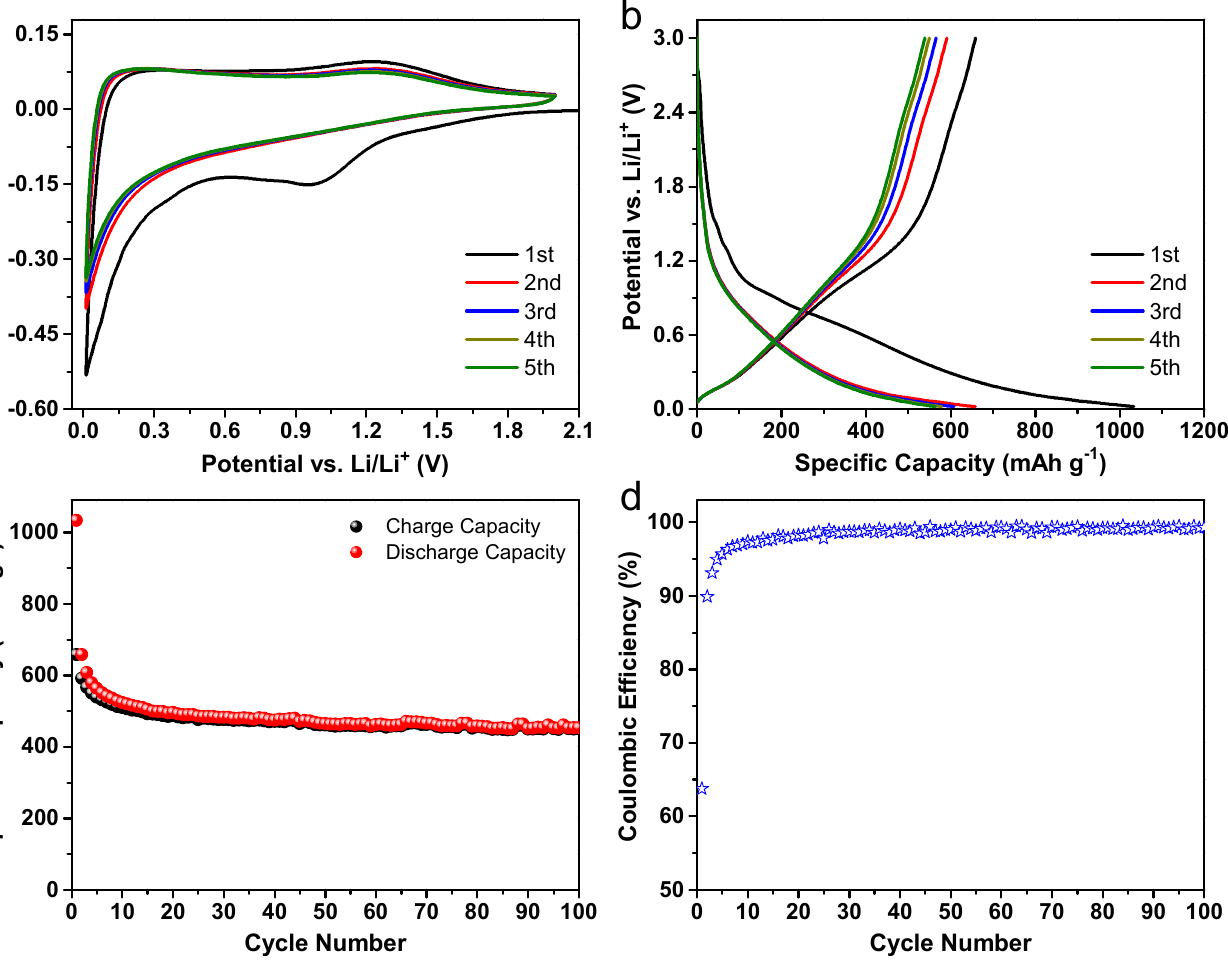
Figure 6. Electrochemical performance of Alg-C electrodes in Li half-cells. ( a ) The initial five-cycle CV profiles within the potential range of 0.02–2.0 V at a scan rate of 0.2 mV s − 1 . ( b ) Galvanostatic discharge/charge curves for the first five cycles. ( c ) Cycling performance at a current density of 100 mA g − 1 with its ( d ) Coulombic efficiency in the potential window of 0.02–3.0 V.